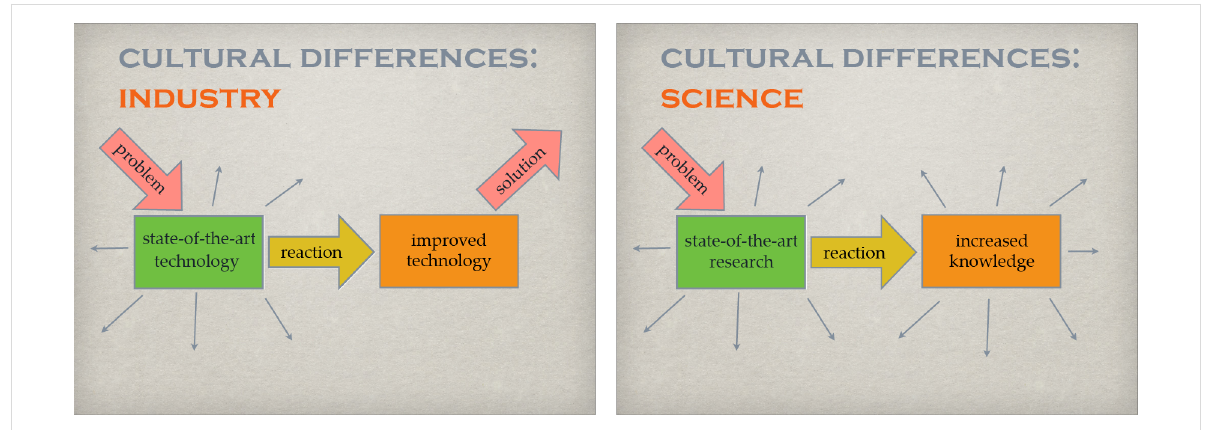
Figure 3: Some of the cultural differences between industry and science.